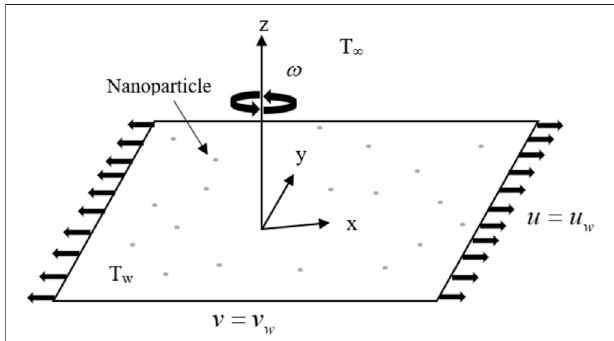
FIGURE 1 | Geometrical interpretation for magnetohydrodynamic-